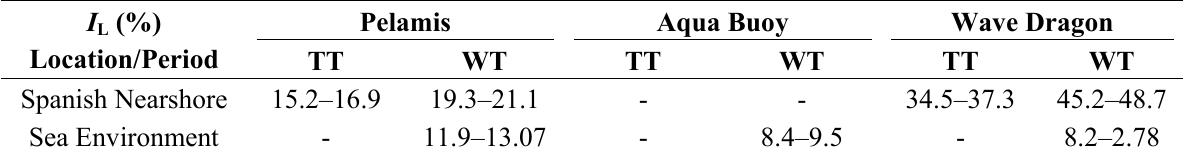
Table 9. Average values of the load factor in the Spanish nearshore and in sea environment (the Black and the North seas). The WECs considered are: Pelamis, Aqua Buoy and Wave Dragon.